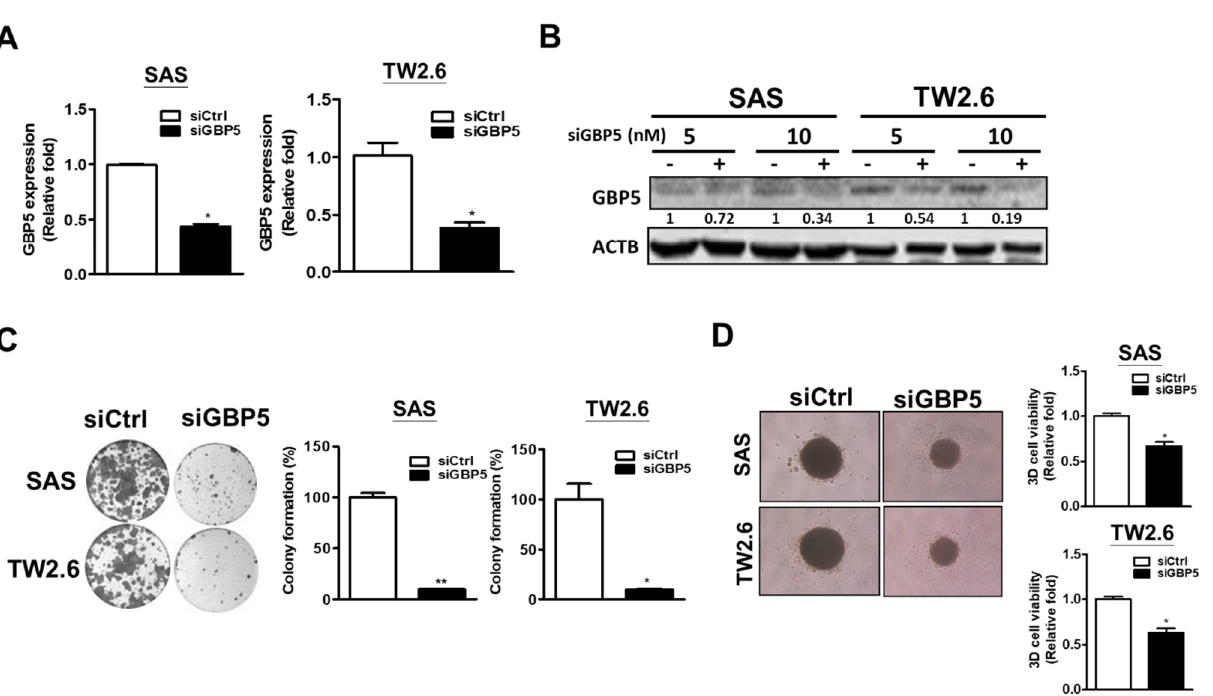
Figure 2. Effects of GBP5 in cell growth of OSCC cells. ( A ) Gene expression levels of GBP5 in transient GBP5–silenced SAS and TW2.6 cells by RT-PCR. All cells were transfected with 10 nM scramble siRNA (siCtrl) or GBP5 siRNA (siGBP5) for 72 h. ( B ) Protein expression levels of GBP5 in transient GBP5–silenced SAS and TW2.6 cells by Western blotting. Beta-actin was used as loading control (ACTB). All cells were transfected with 10 nM scramble siRNA (-) or GBP5 siRNA (+) for 72 h. ( C ) Colony formation of transient GBP5–silenced SAS and TW2.6 cells. After two weeks, these cells were fixed and stained with crystal violet to count the number of colonies. All cells were transfected with 10 nM scramble siRNA (siCtrl) or GBP5 siRNA (siGBP5) for 72 h. ( D ) Formation of tumorspheres and tumorsphere viability of transient GBP5–silenced SAS and TW2.6 cells. Tumorsphere viability was measured by the 3D CellTiter Glo assay. All cells were transfected with 10 nM scramble siRNA (siCtrl) or GBP5 siRNA (siGBP5) for 72 h. All quantitative results are calculated as the mean ± SEM from three independent experiments. A value of p < 0.05 was considered significant (** p < 0.01, * p < 0.05).